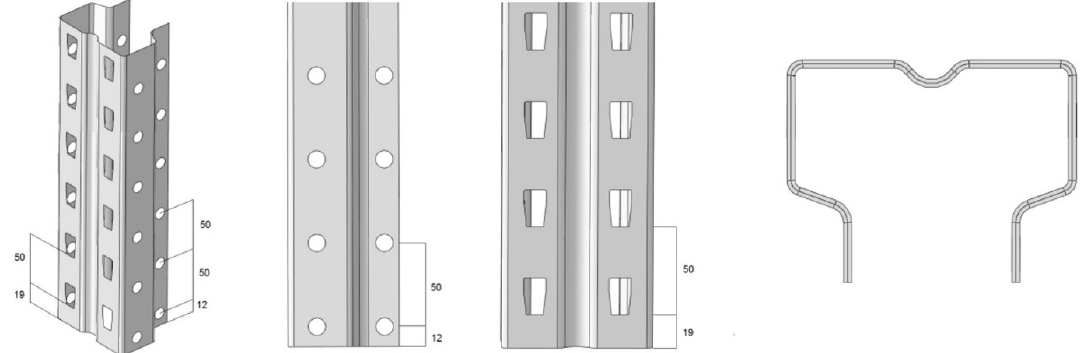
Figure 1. The reinforcement system and the constituent elements: ( a ) graphical section detail and ( b ) upright column in tests.